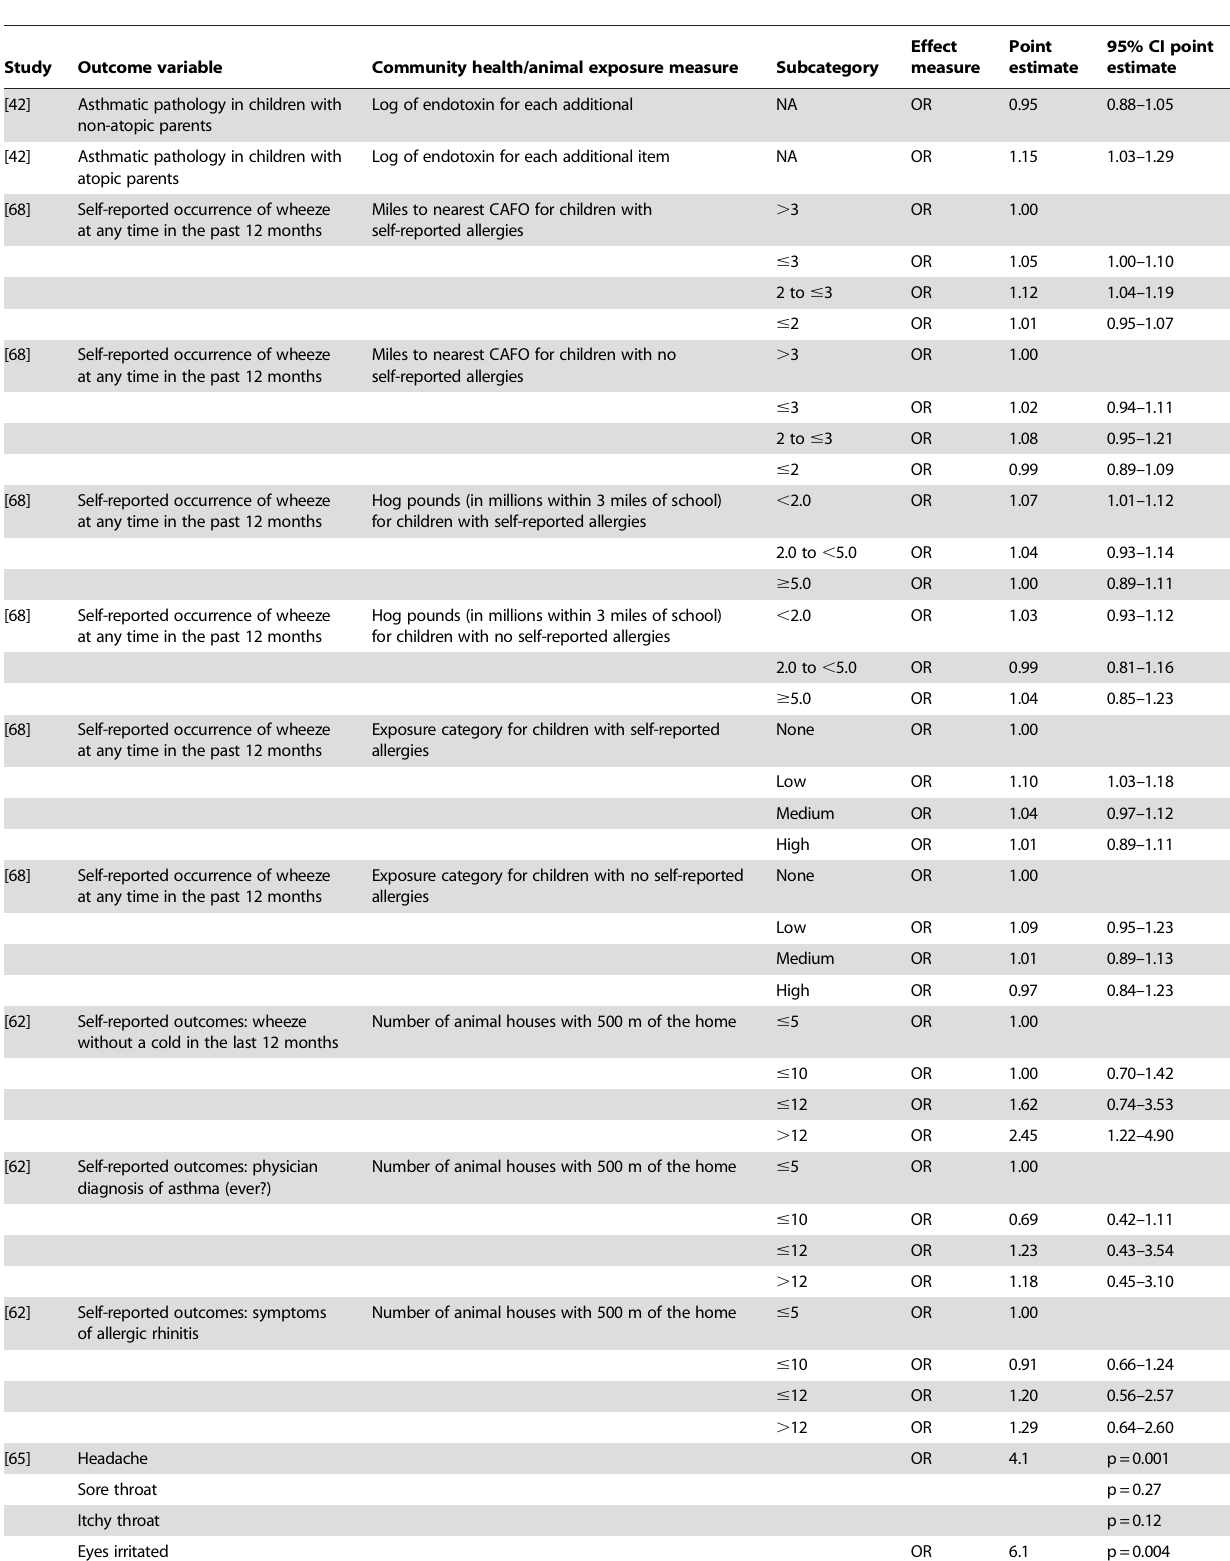
Table 4. The adjusted* association between the self-reported outcome variables and non-odor related explanatory variables in communities near